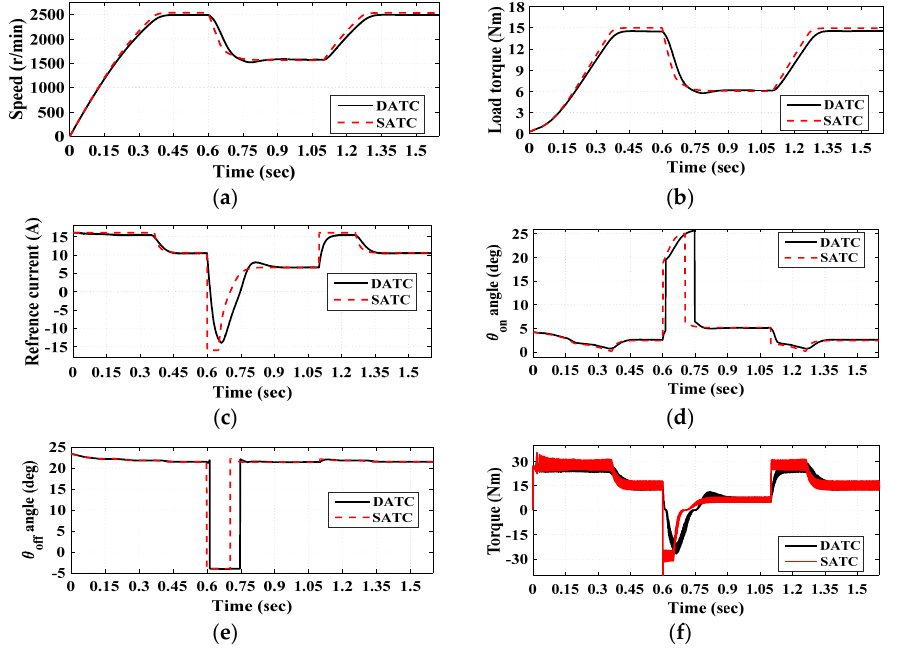
Figure 11. The simulation results with EV acceleration and deceleration: ( a ) motor speed; ( b ) load torque on the motor side; ( c ) reference current; ( d ) the variation of the turn-on angle; ( e ) the variation of the turn-off angle; ( f ) the total electromagnetic torque.